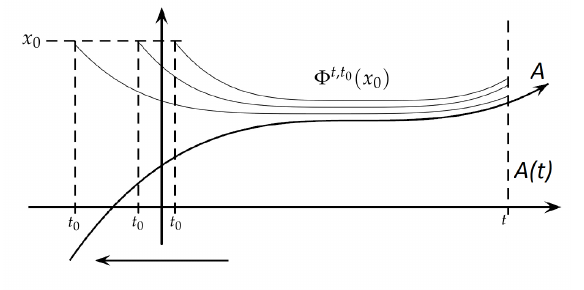
Figure 1. A symbolic visualization of the pullback attractor [2], showing that A ( t ) consists of all values of solutions at time t originating at times t 0 → − ∞ , and the pullback attractor A is the family of all these A ( t )